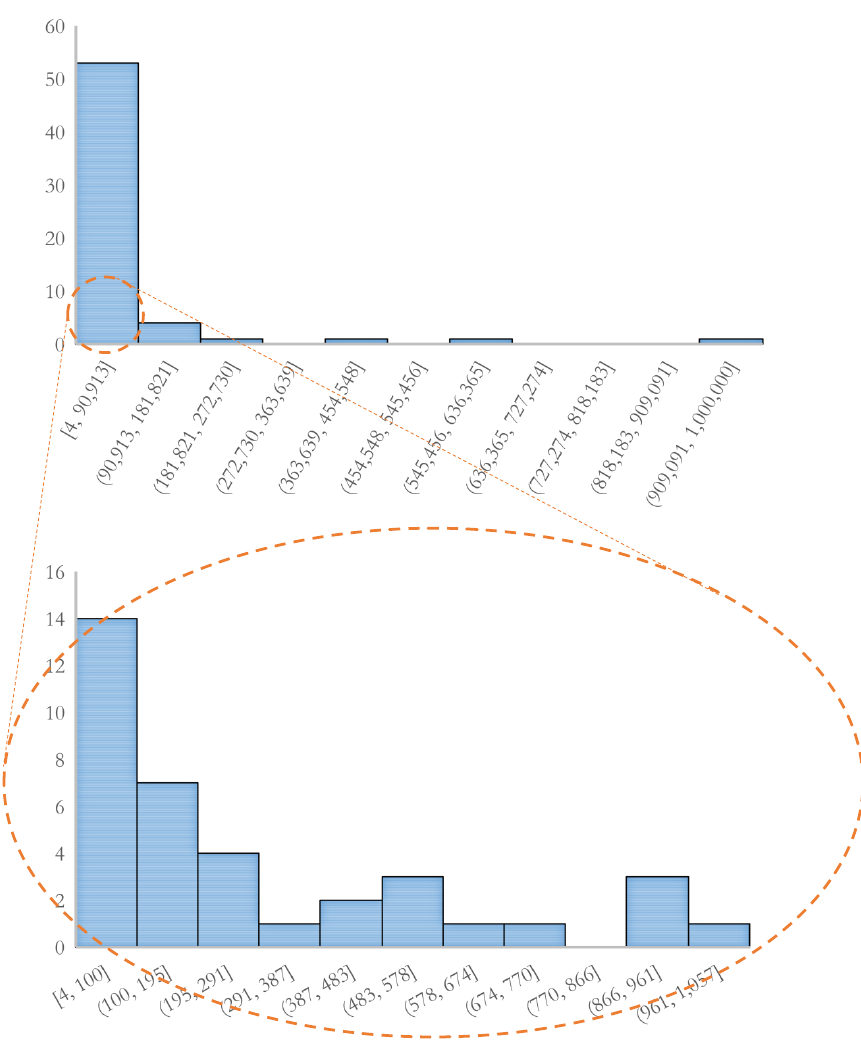
Figure 5. The frequency of the number of buildings simulated in physics-based urban building energy modeling case studies. Researchers study the modeling and simulation techniques in UBEM, and their ad- vantages and disadvantages are compared [7,8]. Boghetti et al. (2020) [7] compared two UBEM development approaches (i.e., physics-based vs. data-driven) and noted that data- driven models rely on many data points and physics-based methods need more extended simulation and preparation time. Because ECM evaluation is one of the areas of study in this paper, the selected papers are focused on physics-based modeling.